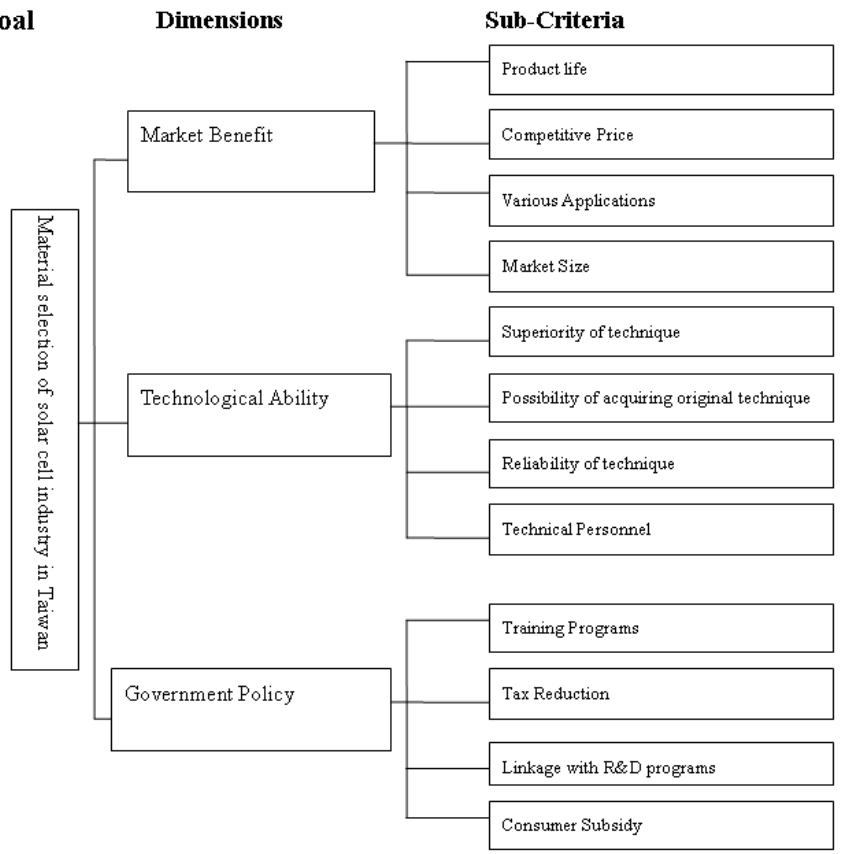
Figure 1. Research evaluation framework.